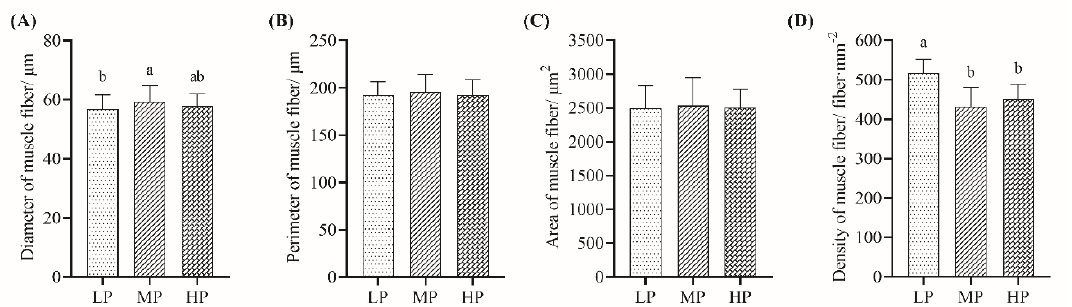
Figure 1. Effects of the three different dietary protein levels on the histological characteristics of longissimus dorsi muscle in Tibetan sheep. ( A ) Diameter of muscle fibers. ( B ) Perimeter of muscle fibers. ( C ) Area of muscle fibers. ( D ) Density of muscle fibers. a, b Indicate significant differences among three groups.